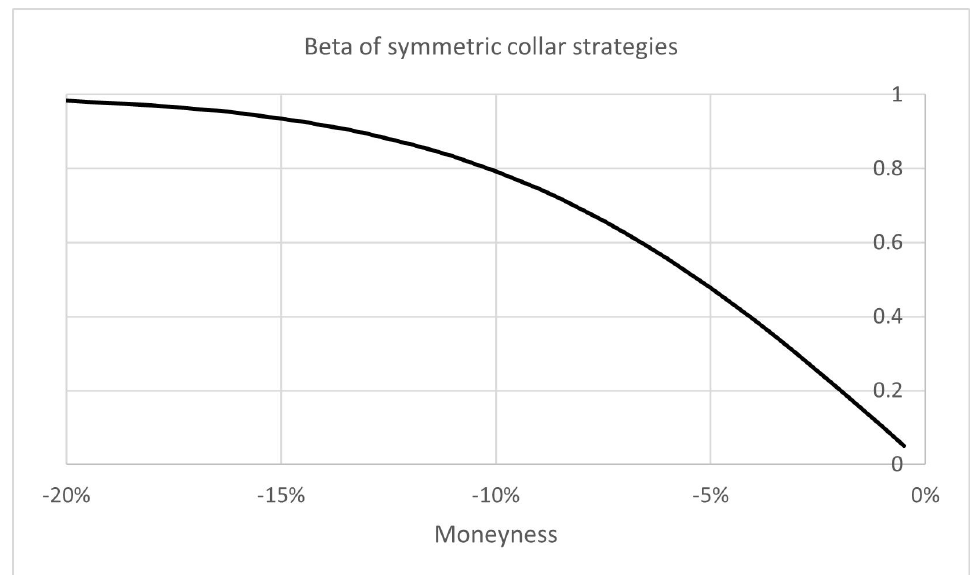
Figure 18. The price sensitivity (beta) of an underlying asset with an overlaid symmetric collar strategy for a range of strike prices in relation to price change of the underlying